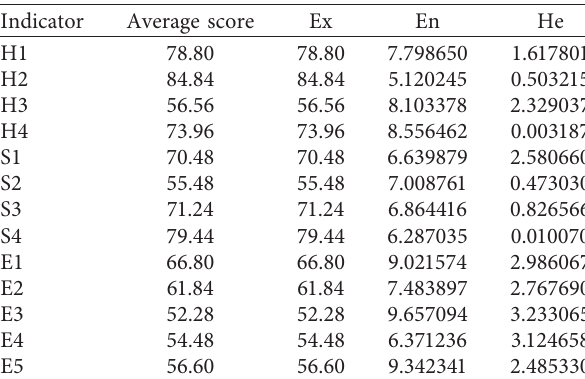
Table 8: The clouds of evaluation